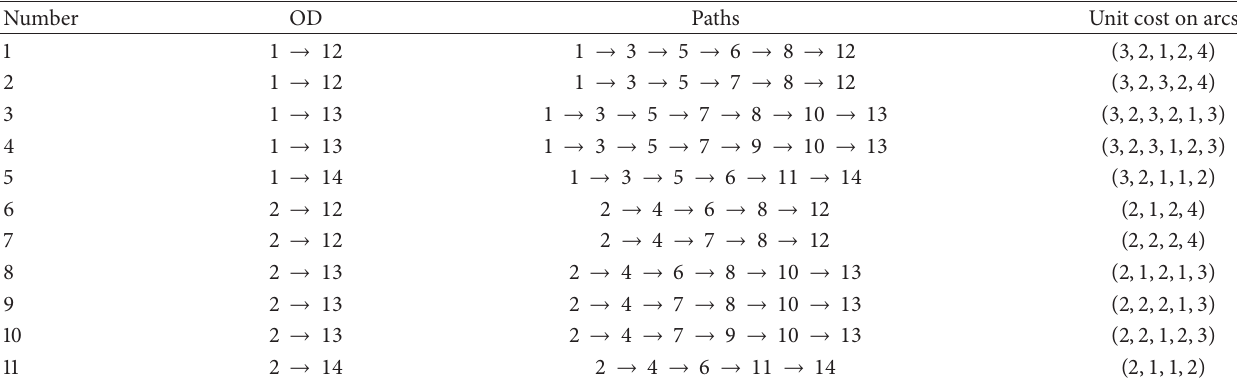
Table 7: The considered paths and unit transportation cost on arcs.